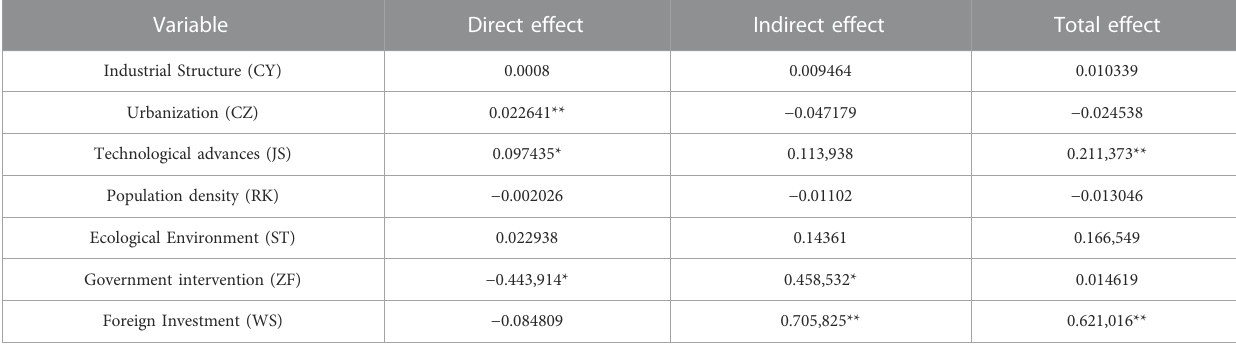
TABLE 2 Direct and indirect effects of the spatial durbin